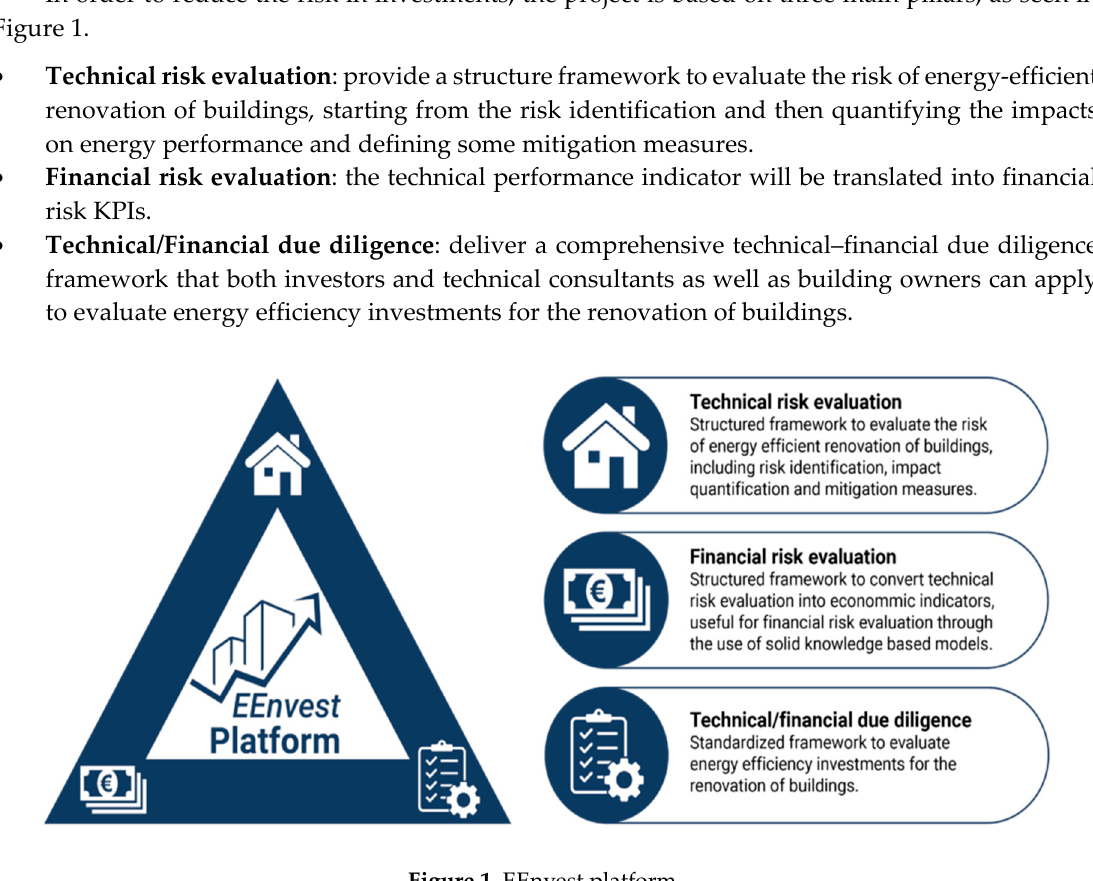
Figure 1. EEnvest